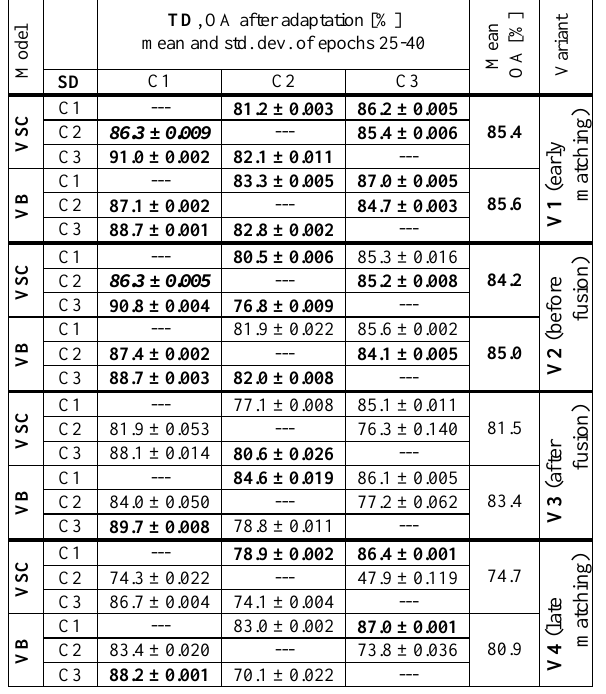
Table 5. Mean OA and standard deviation on the target domain after DA by variants V1-V4 .